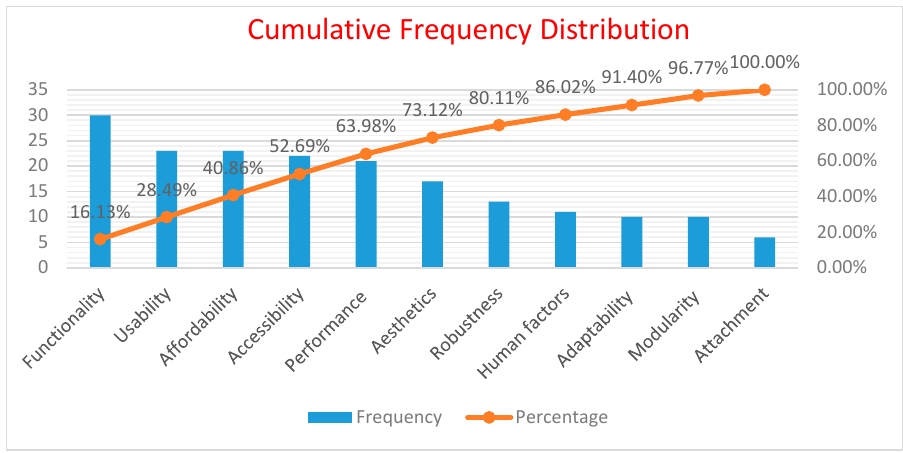
Figure 3. Cumulative frequency distribution analysis chart.